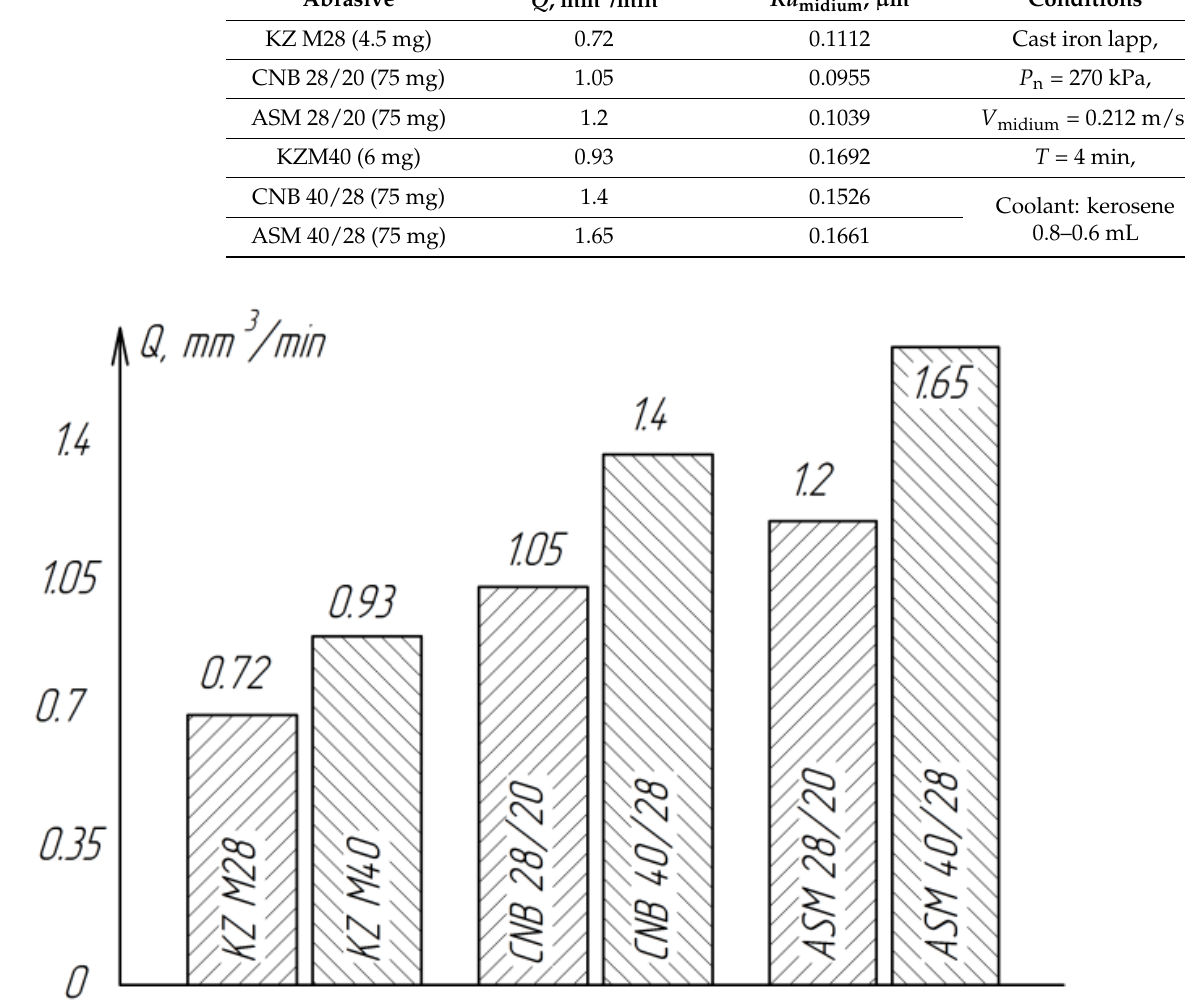
Table 2. Influence of the type and grain size of the abrasive material on the productivity and roughness of the lapped surface. Abrasive